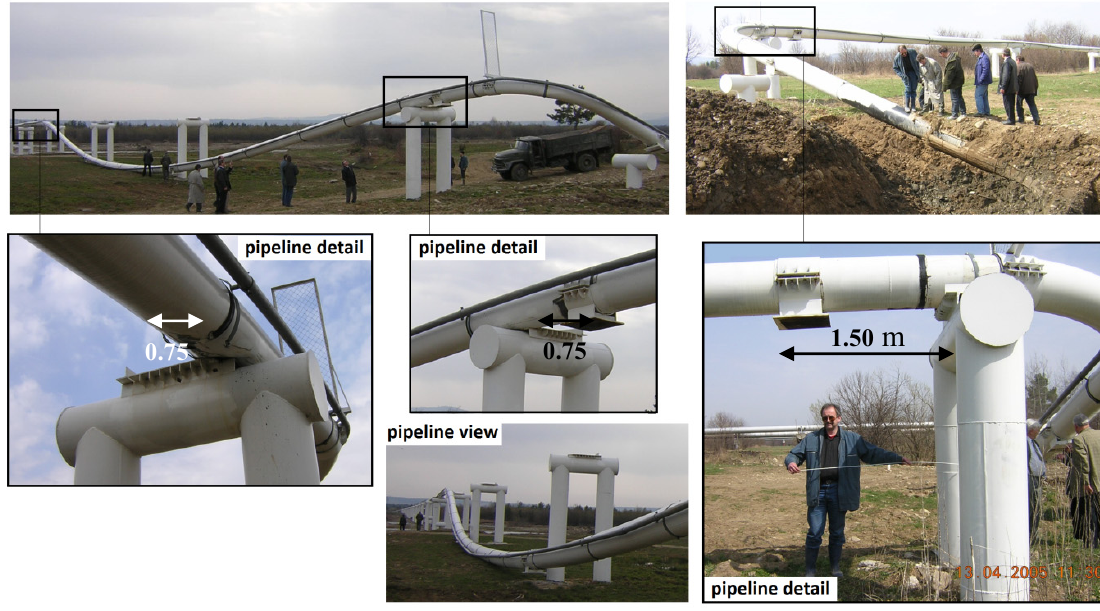
Figure 1. Pipeline accident (adapted from [23]).